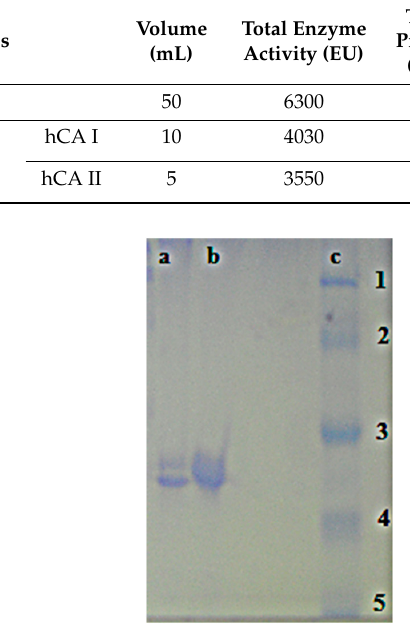
Figure 3. Sodium dodecyl sulphate-polyacrylamide gel electrophoresis bands of carbonic anhydrase I and II isoenzymes and standard proteins. Lanes a : hCA II, b : hCA I, c : standard proteins; standards 1 : 116 kDa ( β -Galactosidase from E. Coli ), 2 : 97 kDa (Phosphorilase from rabbit muscle), 3 : 66 kDa (Bovine serum albumin), 4 : 45 kDa (Ovalbumin), 5 : 29 kDa (carbonic anhydrase from bovine erythrocyte). Table 2. Human carbonic anhydrase isoenzymes (hCA I and II) inhibition value with β -lactam derivatives 2a – k by an esterase assay with p -nitrophenylacetate (NPA) as a